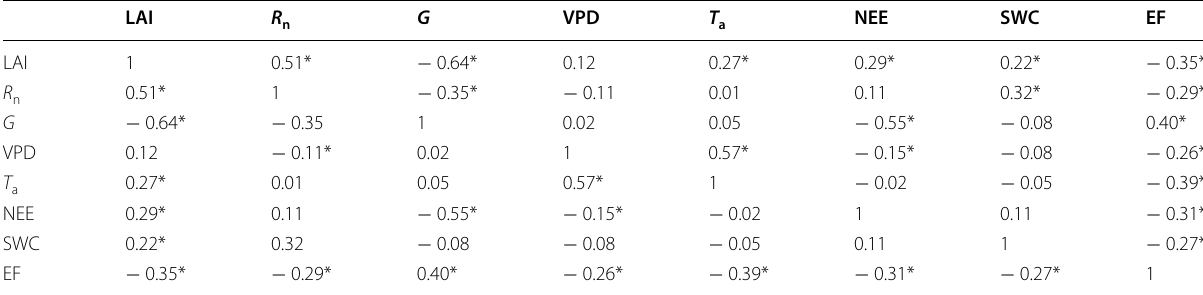
EF is the dependent variable *Significant correlation ( p values <